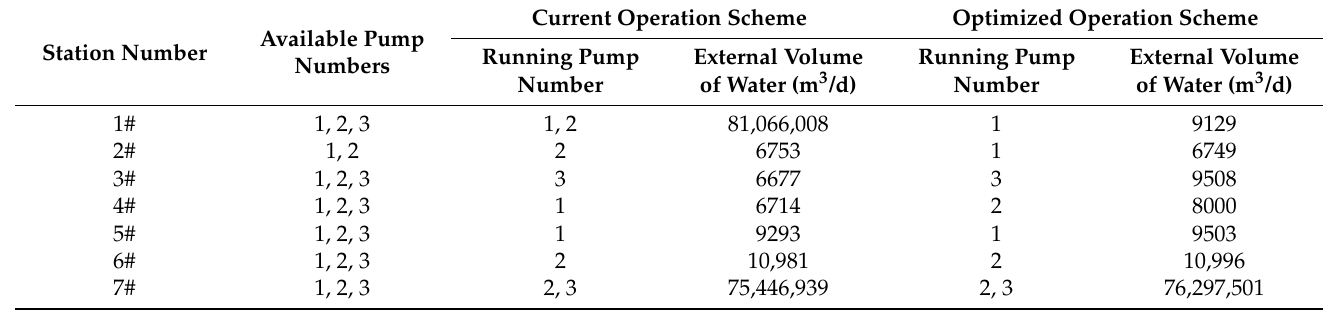
Table 2. Contrast result of before and after operation scheme optimization on low-pressure water- flooding system.